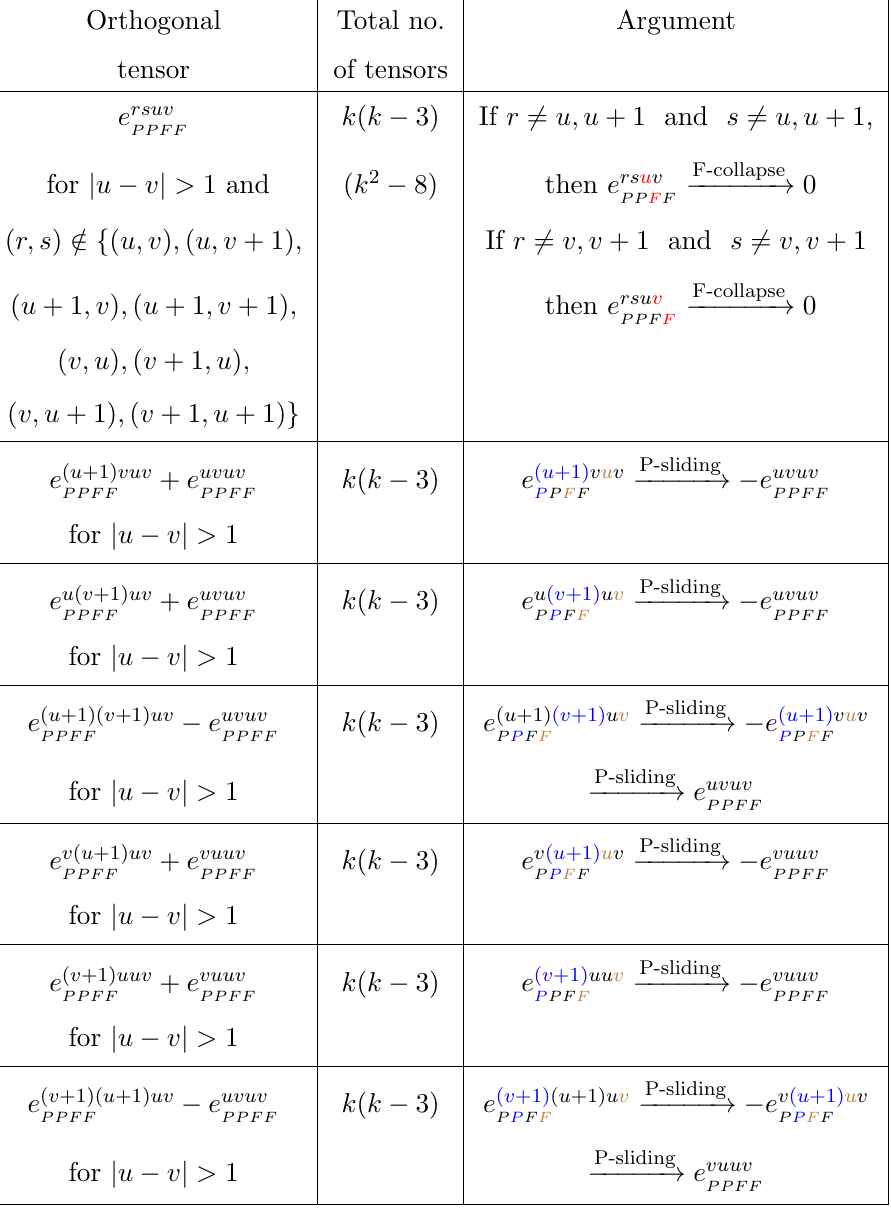
Table 9 . Arguments for the tensors in the PPFF sector orthogonal to the array of 4 point contour